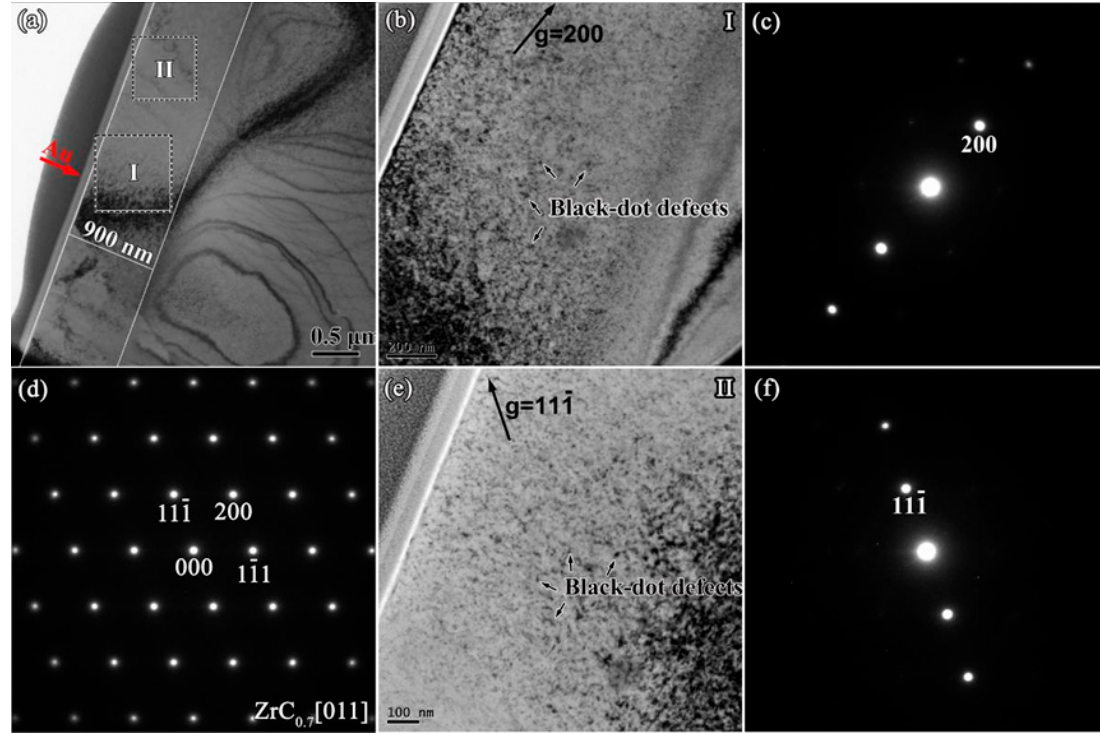
Figure 9. ( a ) Cross-section BF-TEM images of ZrC 0.7 after irradiation; ( b ) BF image of irradiated ZrC 0.7 at Region I, taken from ( c ) a two-beam condition diffraction pattern with g = 200 near the zone axis [011]; ( d ) SAED patterns obtained from the zone axis [011] of the damaged area; ( e ) BF image of irradiated ZrC 0.7 at region II taken from ( f ) a two-beam condition diffraction pattern with g = 111 near the zone axis [011].